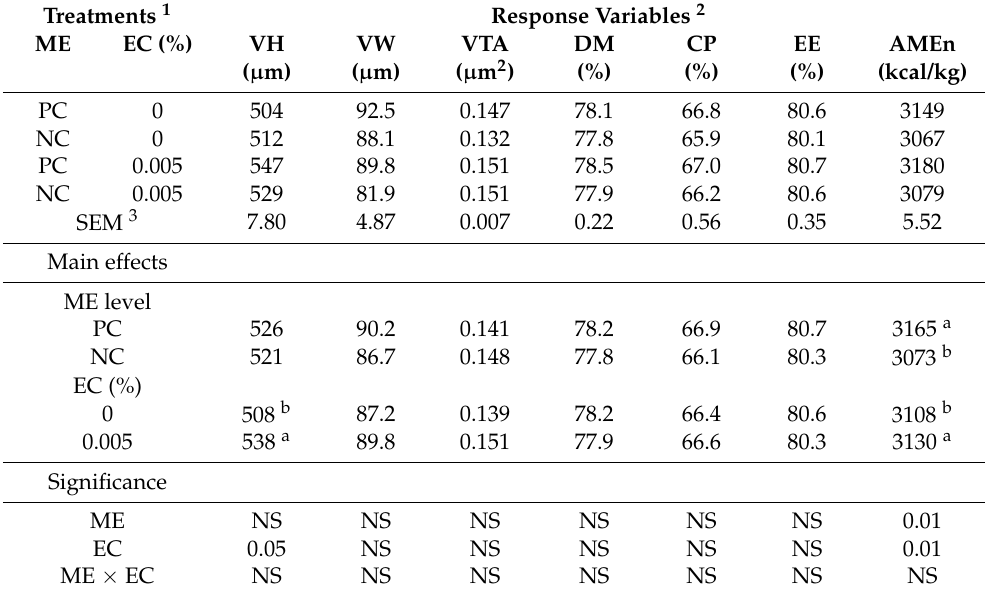
Table 5. Effect of dietary metabolizable energy (ME) level, enzyme cocktail (EC) supplementation, and their interaction on ileal morphology at 35 days and apparent retention of nutrients in broilers over 35–38